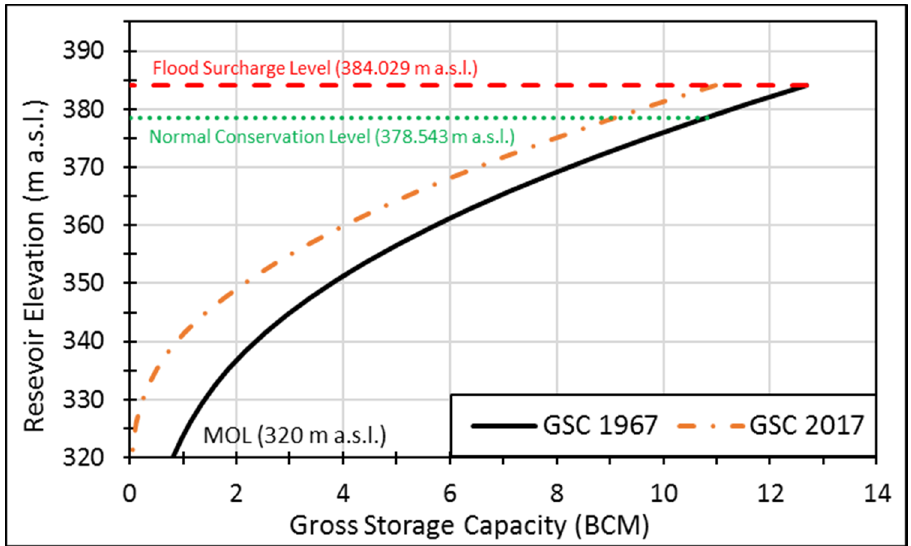
Figure 2. Stage-storage capacity curve for the Mangla Reservoir.